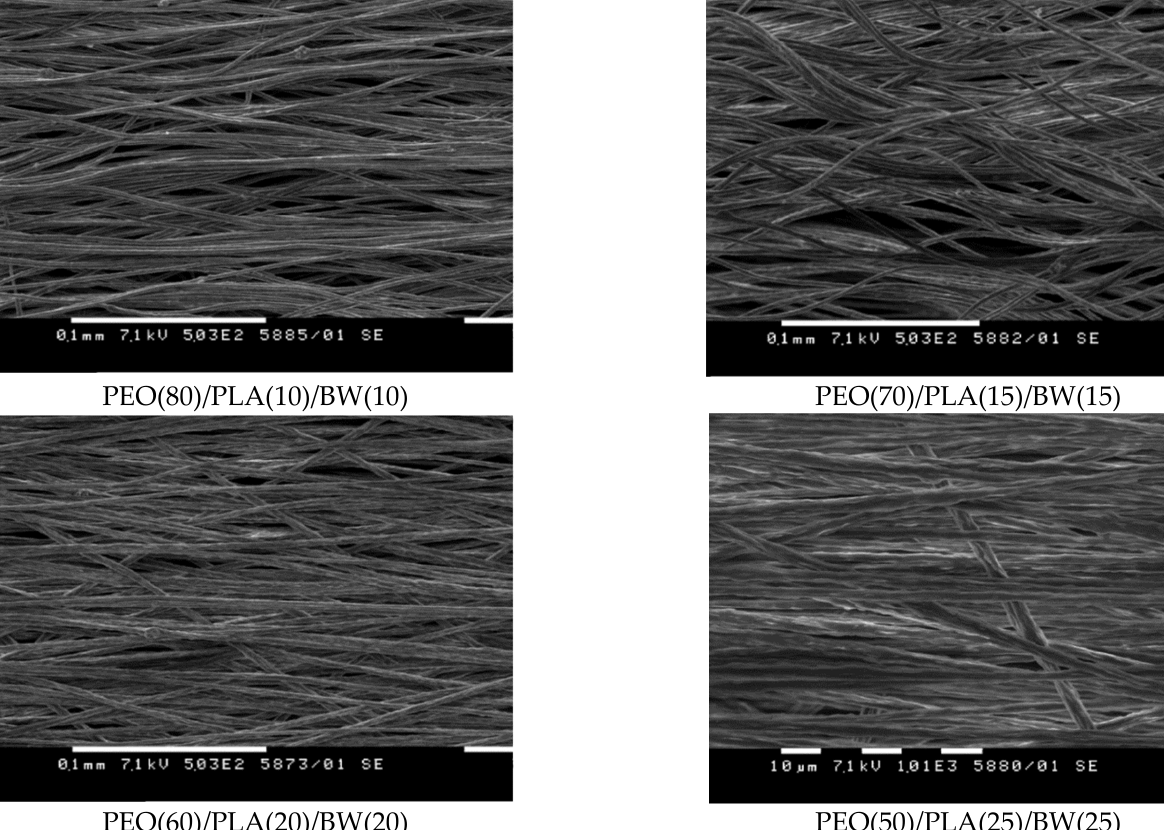
Figure 1. SEM micrographs of PEO/PLA/BW fibrous materials prepared by electrospinning at different weight ratios (shown under each micrograph) between the partners and at equal PEO concentration in the spinning solution. Magnification: ×500.